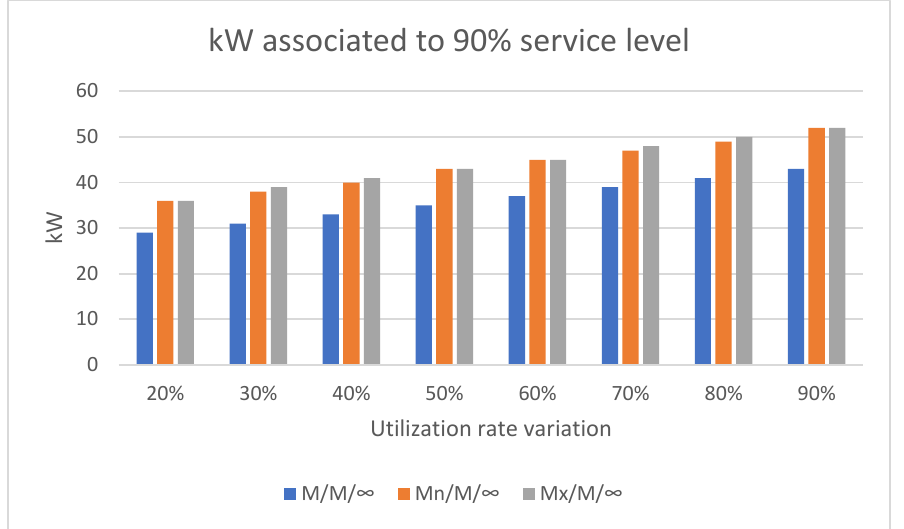
Figure 5. kW value required for 90% service level by varying the utilisation rate of the three mod- els.